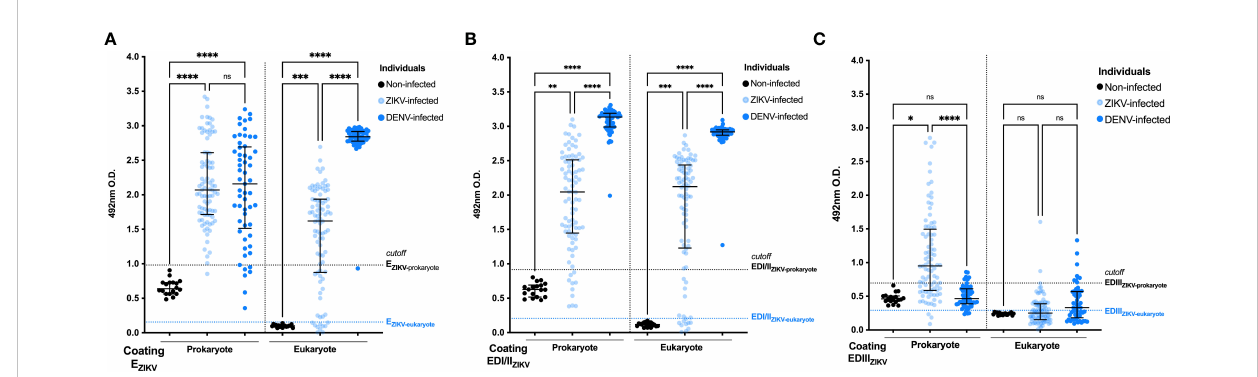
FIGURE 1 Antigenicity of ZIKV+ and DENV+ sera against recombinant prokaryote and eukaryote EZIKV, EDI/IIZIKV and EDIIIZIKV. Speci fi city analysis of humoral responses using sera from ZIKV and DENV patients against prokaryote and eukaryote proteins: (A) E ZIKV , (B) EDI/II ZIKV and (C) EDIII ZIKV . Serum samples from infected individuals (ZIKV + or DENV + ) are represented in blue circles and samples from negative controls (non-infected) in black. Cutoff: mean O.D. of serum from negative controls plus 3 standard deviations (represented in dashed lines). Statistical signi fi cance was measured by nonparametric test Kruskal-Wallis followed by Dunn ’ s post hoc test for multiple comparisons, *p<0.05, ** p<0.01, ***p< 0.001, ****p<0.0001, ns, not signi fi